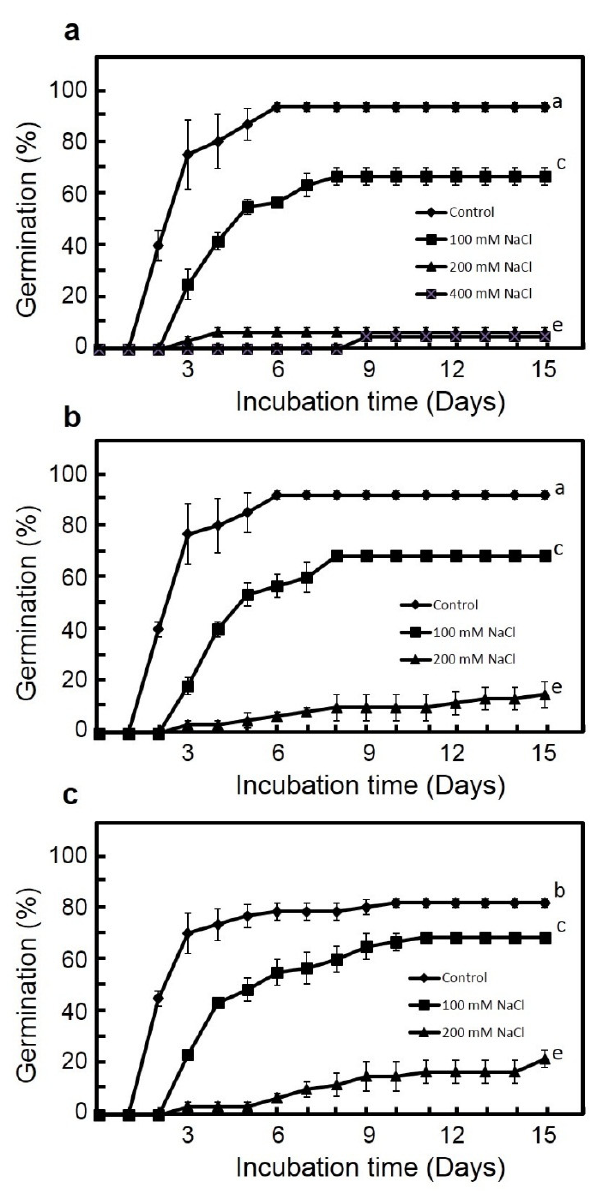
Figure 2. Germination of Zygophyllum coccineum seeds from ( a ) Manzala coast, ( b ) Wadi Asyuti and ( c ) Wadi Houf in distilled water, 100, 200 and 400 mM NaCl for 15 days. Value represents 3 replicates ± standard error. For variables denoted with the same letter, the difference is not statistically significant.